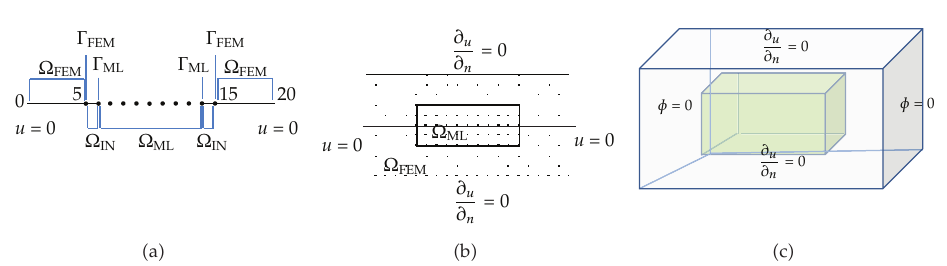
Figure 3: Test problems. In these problems, numbers, variables, and solutions are unitless. (cid:2) a (cid:3) 1D, (cid:2) b (cid:3) 2D. The solid line along y (cid:8) 5 is the cross-sectional line for error evaluation, and (cid:2) c (cid:3) 3D.